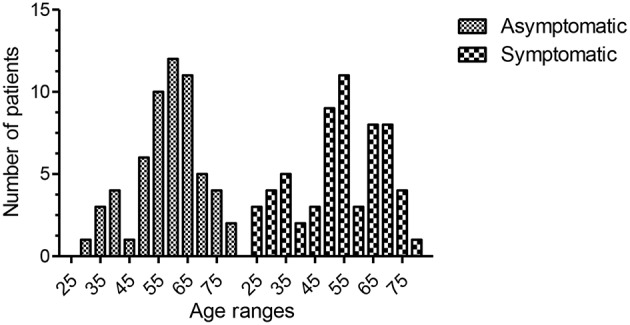
Age ranges of the two groups. The mean age for the entire asymptomatic group was 58.16 (95th CI of mean = 55.18–61.16, range 29–79, sd 11.4, 25th percentile = 50, 75th percentile = 76). The mean age for the entire symptomatic group was 54 (95th CI of mean = 50.2–57.7, range 25–79, sd 14.4, 25th percentile = 45, 75th percentile = 67). There was no statistical difference between the two groups (p = 0.079, unpaired t-test).